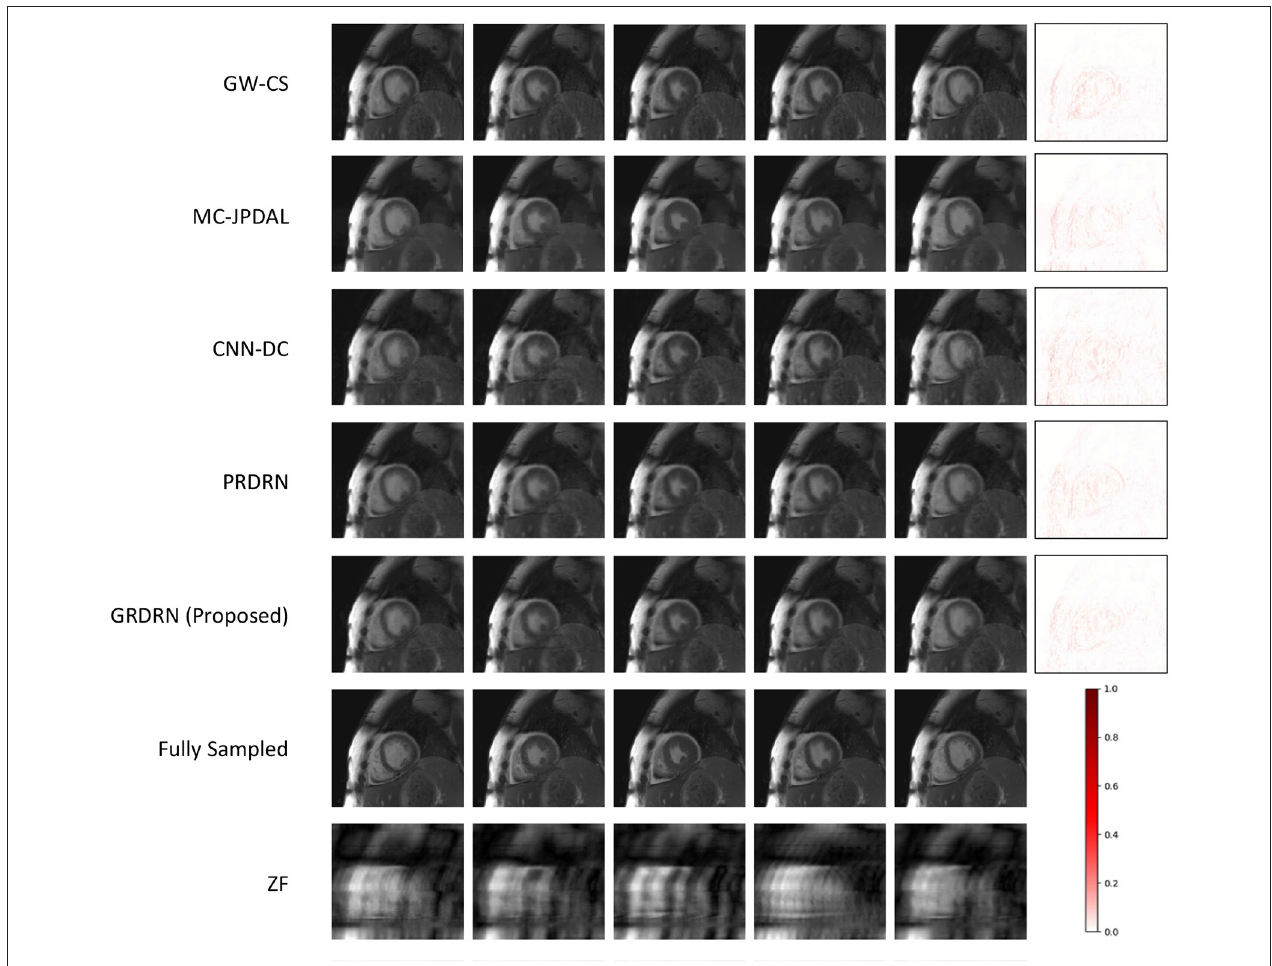
FIGURE 3 | Visualization of reconstructed images as well as the fully sampled and zero-filling (ZF) reconstructed images for five representative frames (systolic to end-diastolic) in the case of acceleration rate 12 × . The last column shows the difference maps between the reconstructed and ground-truth images for the frame in the fifth column. The color bar represents the magnitude of the error in the difference